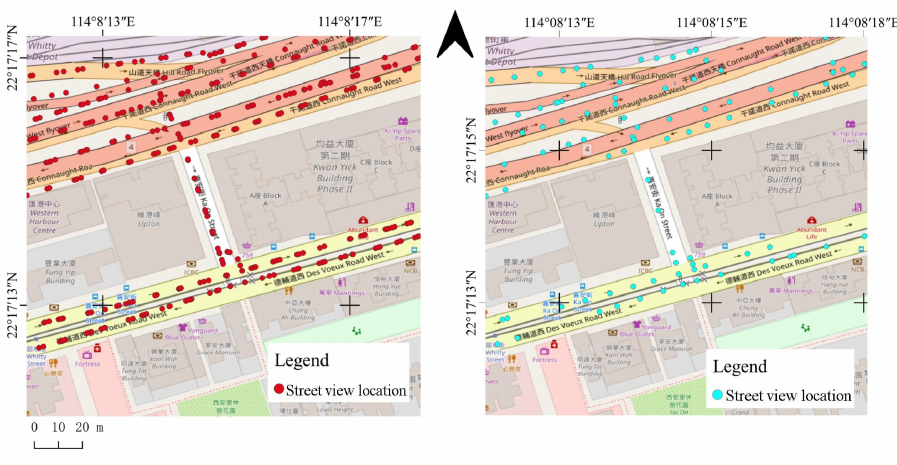
Figure 8. Effect of sparsing process performed on street-level sampling points: left is before process; right is after process. Streetview sampling points become